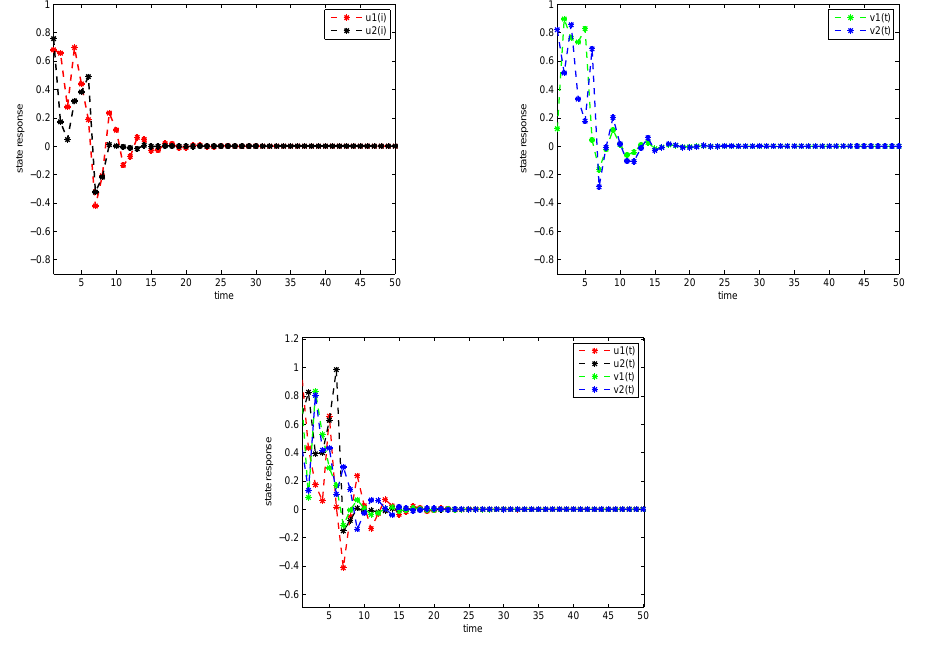
Figure 1. The state response u ( i ) and v ( i ) of